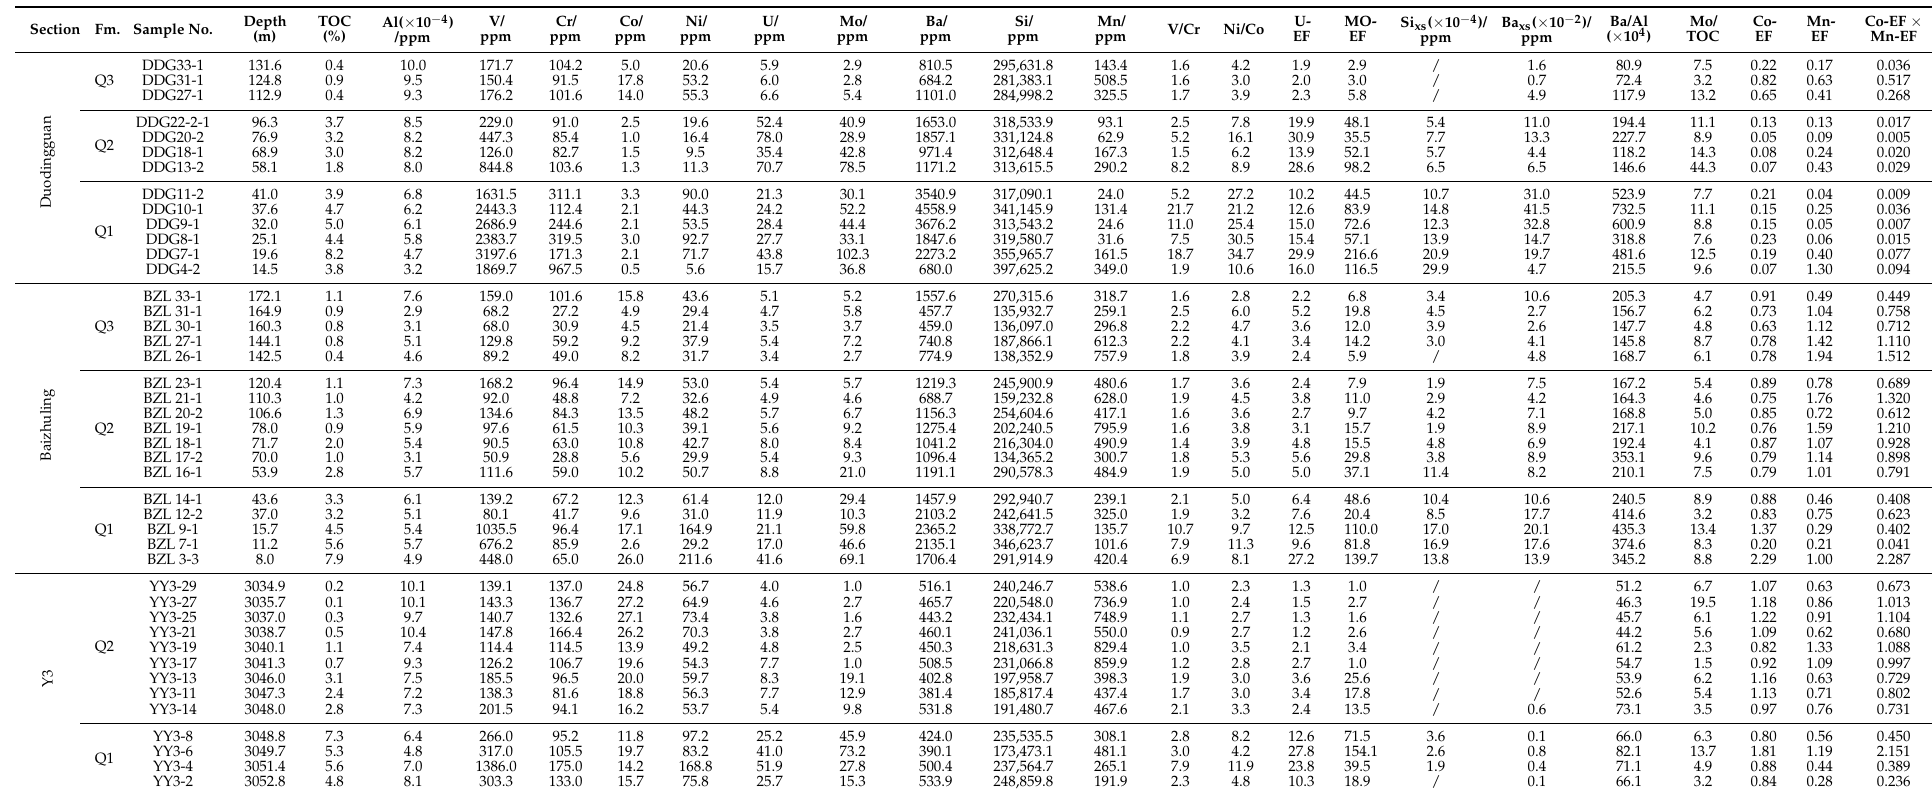
Table 1. Calculated major and trace element compositions of the slope, deep-water shelf, and shallow-water shelf zones in the Qiongzhsi Formation in the western Middle Yangtze Block. Section Fm.